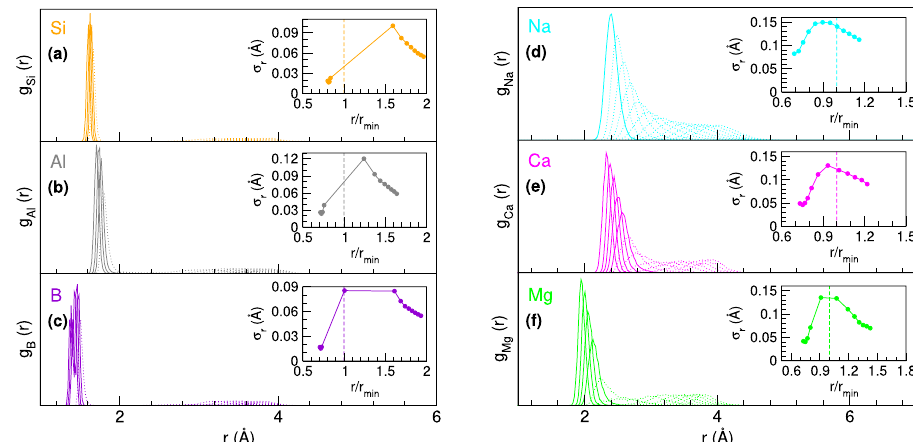
Fig. 3 Partial pair correlation function for the different cations and their 12 nearest neighbors in the N19M8 glass, with addition of calcium contribution from N19C8 as a comparison. a – f Refer to Si, Al, B, Na, Ca and Mg environment respectively. Dashed lines correspond to a large distribution of environments. Insets display the mean radial excursion value of the 12 nearest neighbors as a function of their distance to the considered element, rescaled by the minimum value of the partial pair correlation r min . Dashed lines in insets allow to distinguish fi rst (<1) and second (>1) shell of neighbor.